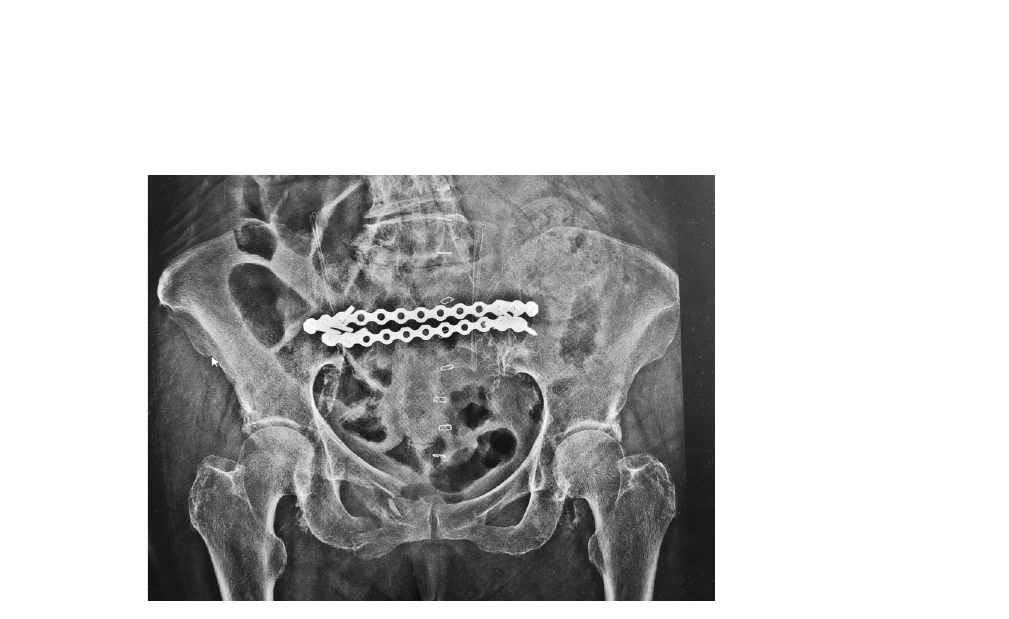
Figure 3. Postoperative CT of the posterior pelvis showing the sacral fractures fixed with ilioiliac plates. One screw on the right side is touching the sacral foramen.